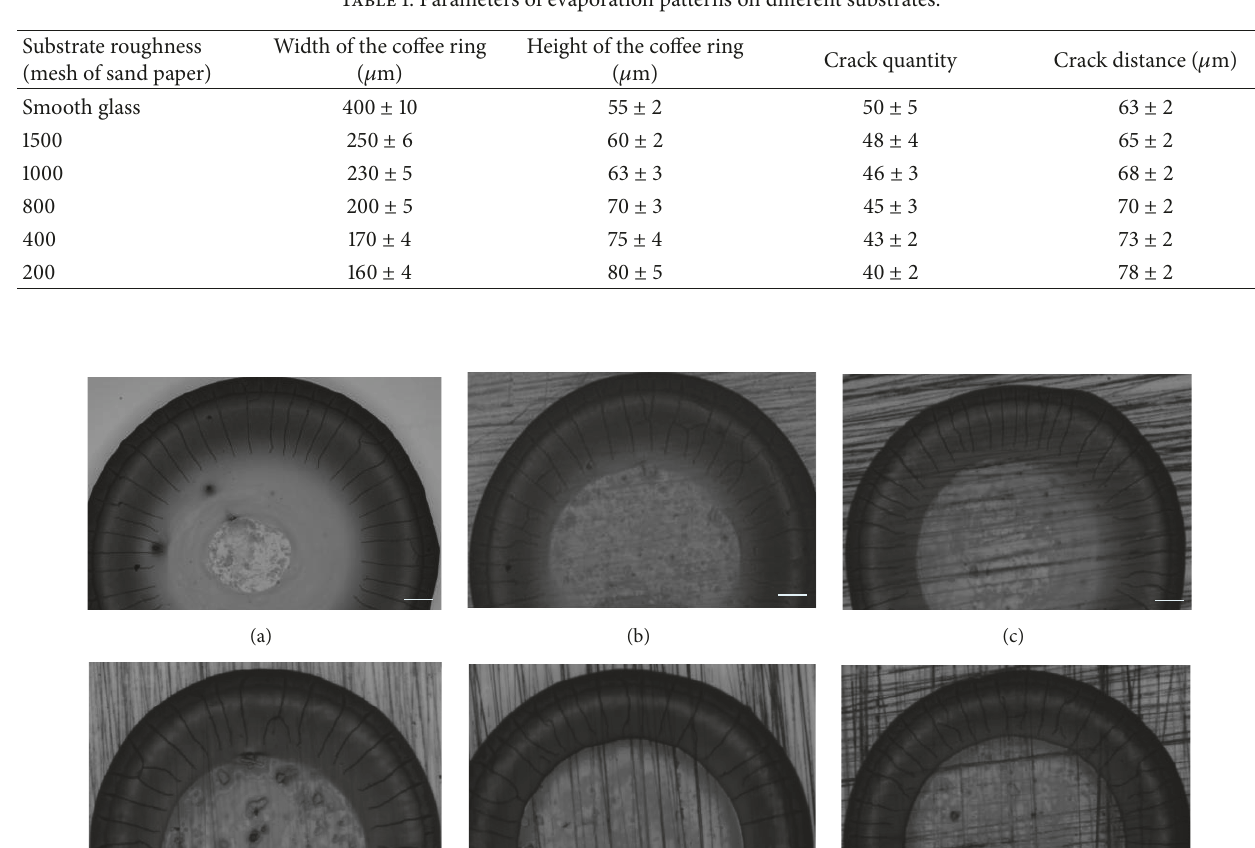
Table 1: Parameters of evaporation patterns on different substrates.